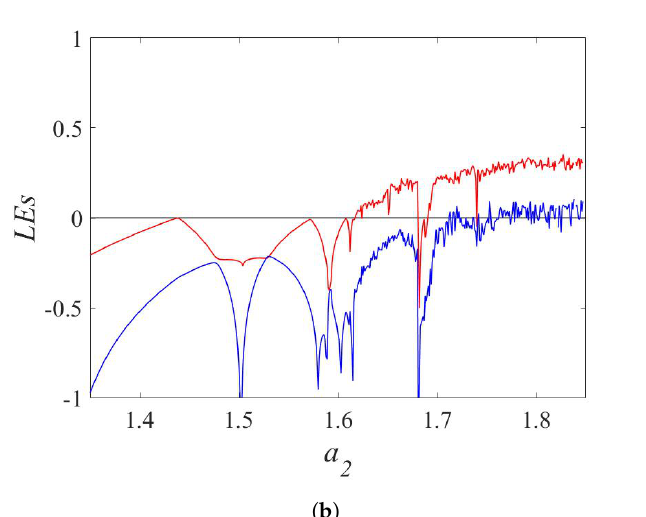
Figure 4. By varying a 2 of the FPFM 1 map from 1.35 to 1.85 ( a ) bifurcation diagram, ( b ) Lyapunov exponents are obtained.